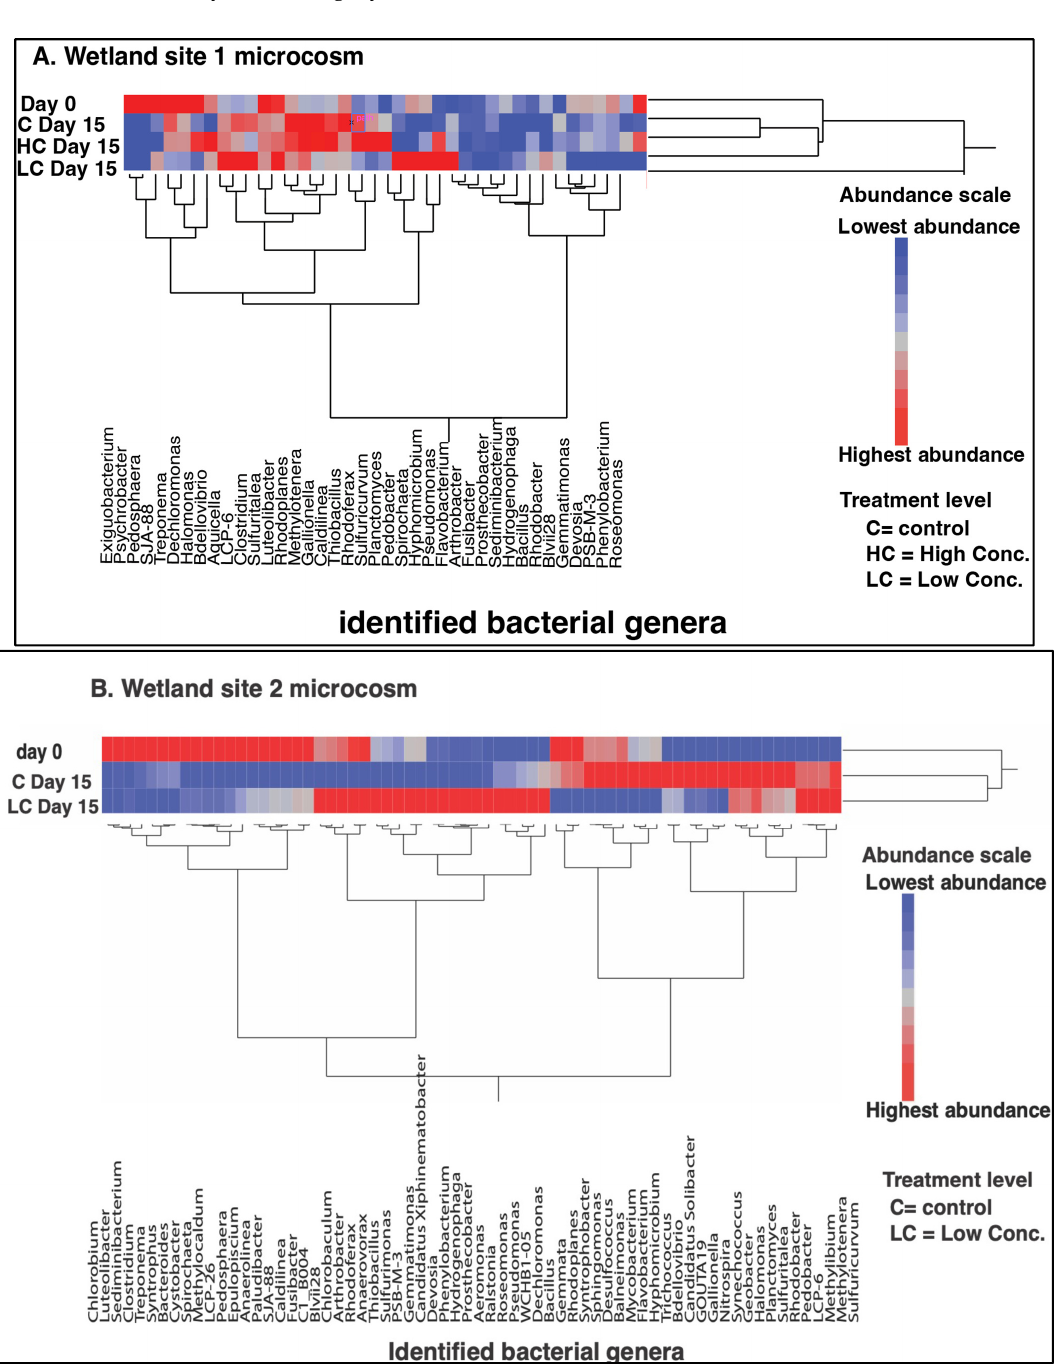
Figure 9. Hierarchical cluster analysis of the bacterial genera detected in the sediments of the treatments of wetland site 1 ( A ) and 2 ( B ) metal microcosm, where day 0 = beginning treatment of the metal microcosm experiment; C Day 15 = treatment of the metal microcosm experiment of the native control sediment with no metals added; LC Day 15 = end treatment (day 15) of the metal microcosm experiment with metals (Pb and Cu) added in lower concentrations in the water to the sediment; HC Day 15 = end treatment (day 15) of the metal microcosm experiment with metals (Pb and Cu) added in higher concentrations in the water to the sediment, as illustrated in the experimental design under Table